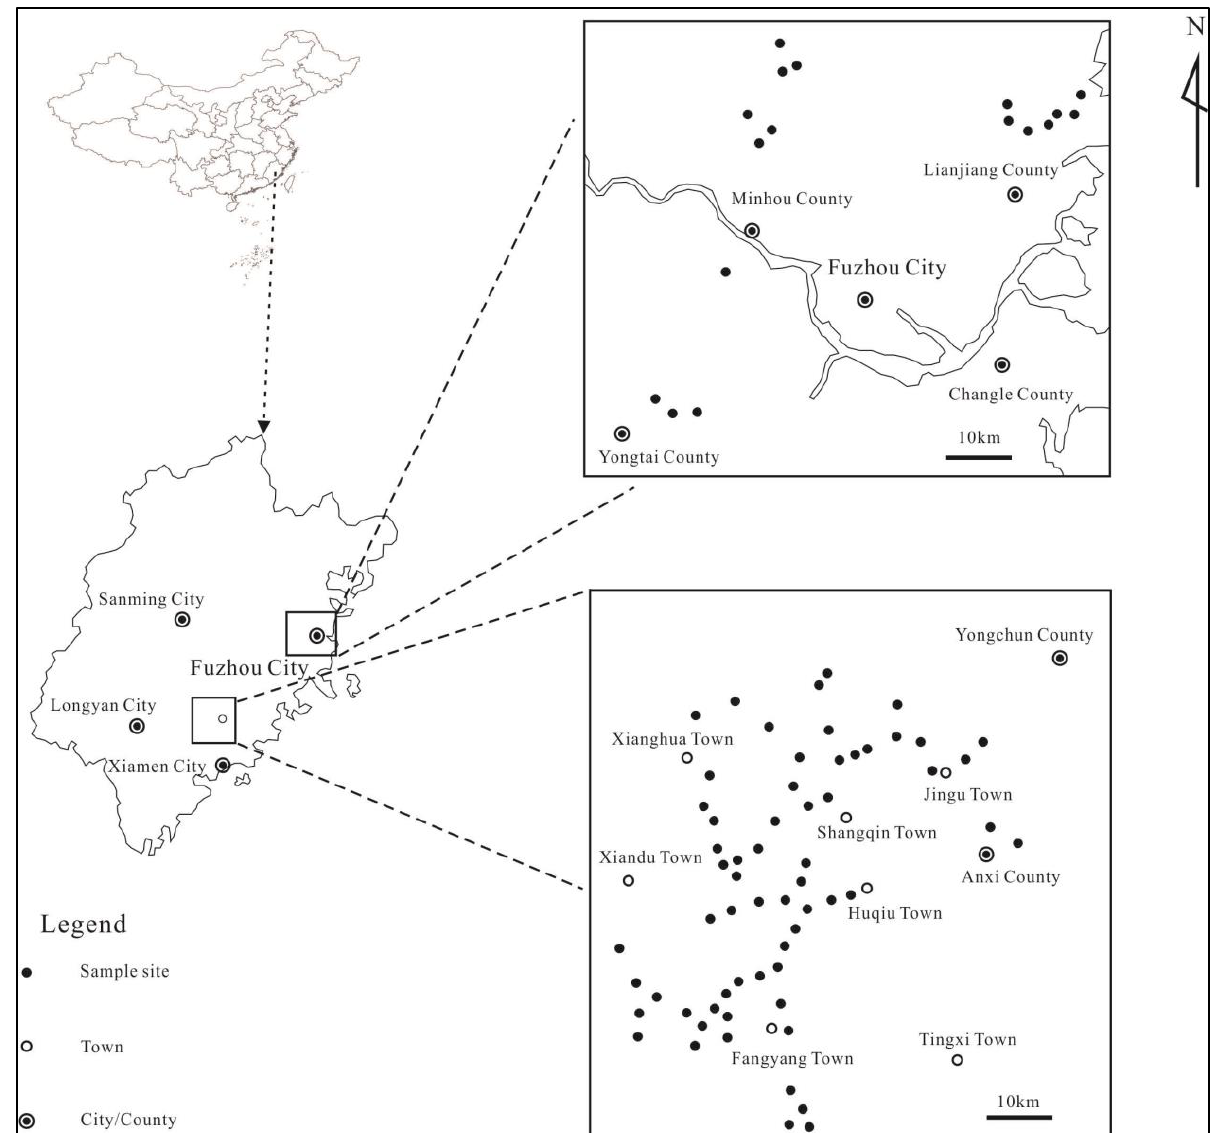
Figure 1. Location of study area and sample sites.